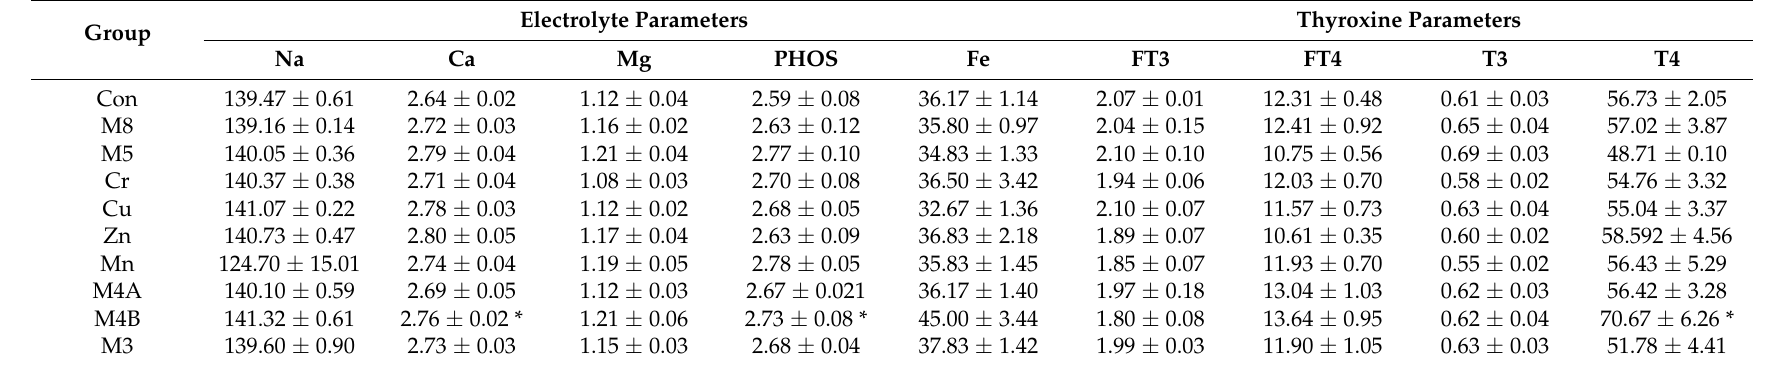
Table 5. Serum electrolyte and thyroxine parameter